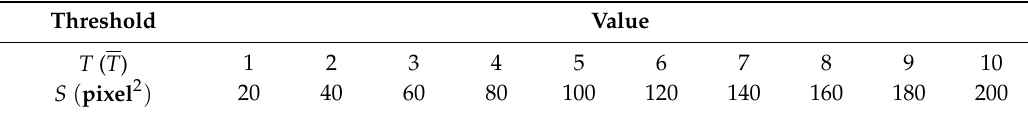
Table 8. Combination of T and S.